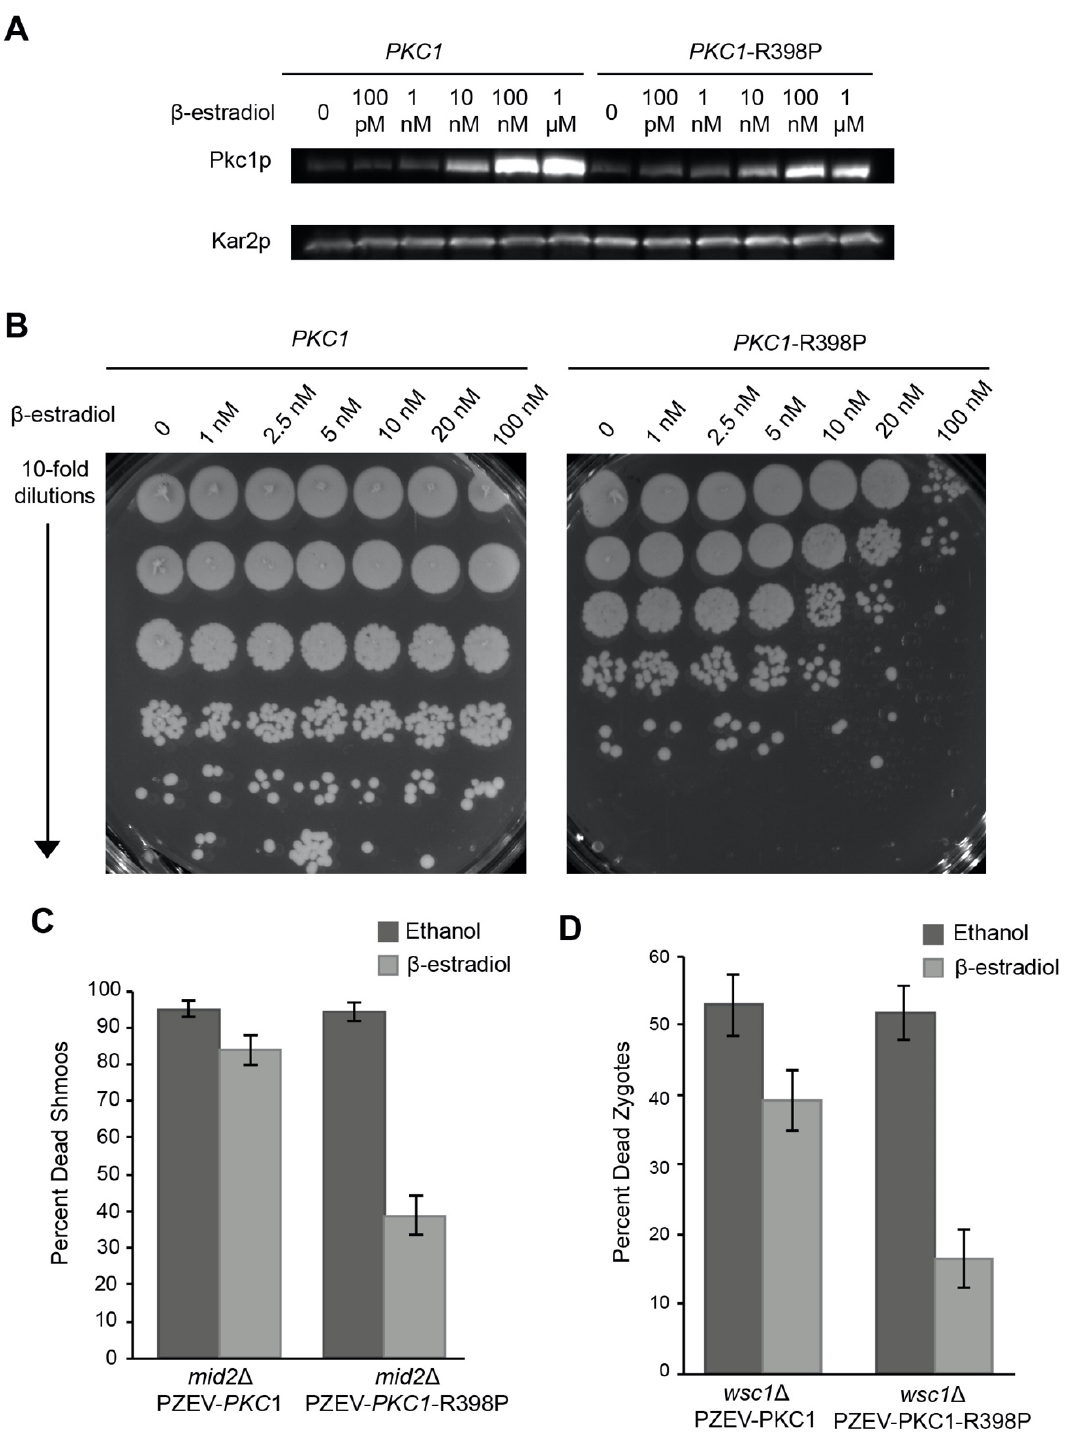
Figure 6. Hyperactivation of PKC1 -R398P causes growth arrest and suppresses wsc1 ∆ zygote death. ( A ) P Z3EV promoter allows fine control of Pkc1p and Pkc1p R398P protein expression. P Z3EV - PKC1 (MY15622) and P Z3EV - PKC1 -R398P (MY15623) were exposed to varying concentrations of β -estradiol for 30 min. An α -Pkc1p antibody was used to detect protein levels